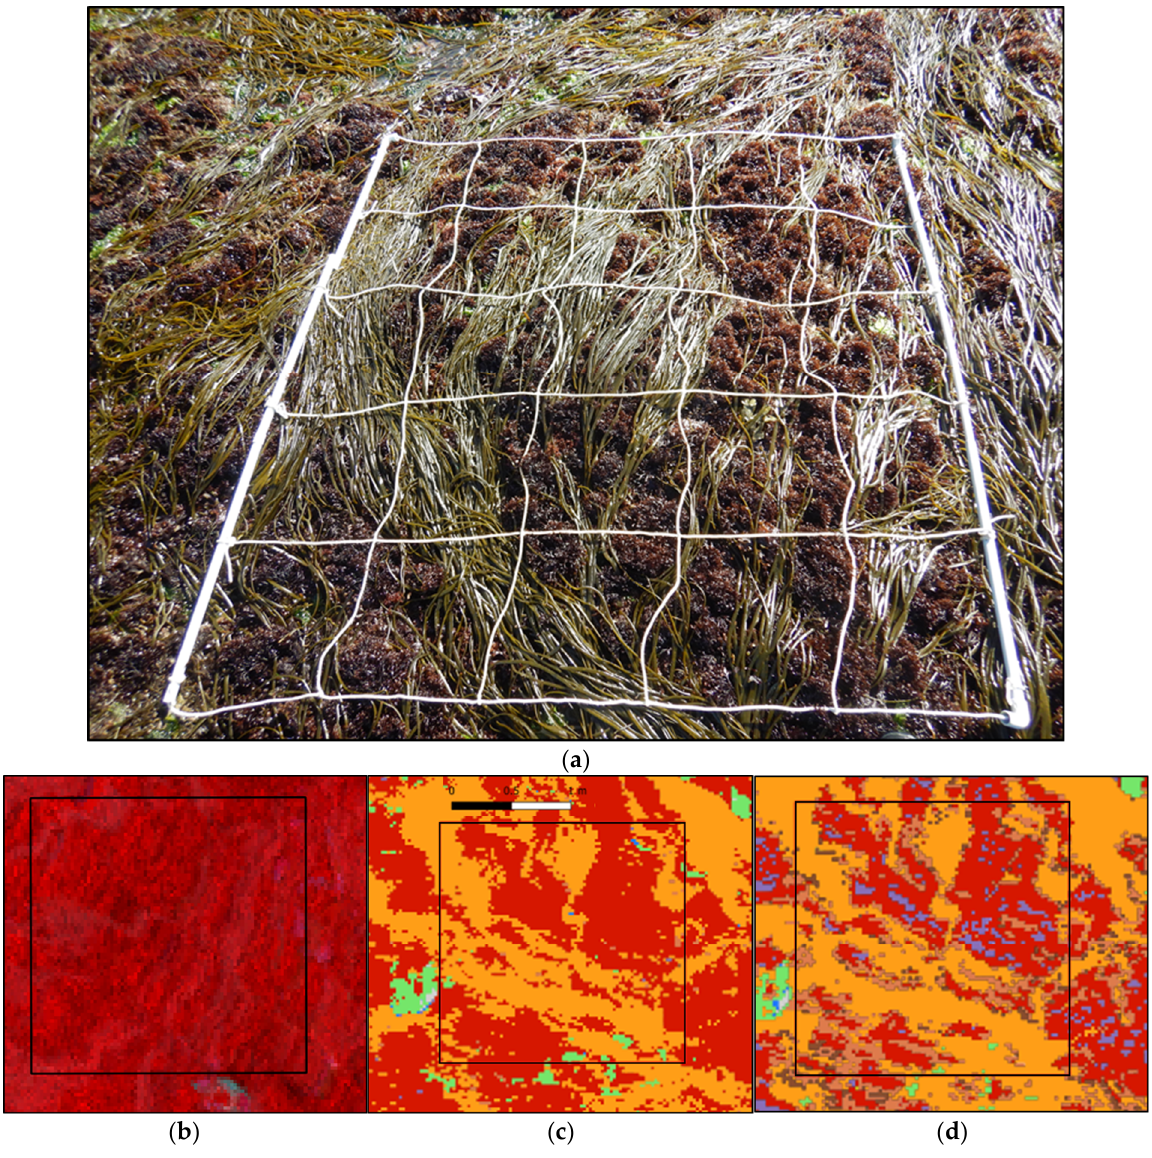
Figure A3. ( a ) Picture of a sampling spot on the He-Ld level at Porspoder taken during field sampling in April 2021. ( b ) NIR-G-B image of the same sampling spot. ( c ) Result of the MLC classification. ( d ) Result of the SAM classification. The black square corresponds to the mobile grid structure used for field sampling. Color code in ( c , d ) corresponds to the following classes: ‘ P. canaliculata ’ (brown), ‘ A. nodosum ’ (purple), ‘ F. serratus ’ (Coral), ‘ H. elongata ’ (orange), ‘Red’ algae (red), ‘Green’ algae (green), ‘Substratum’ (grey) and ‘Water’ (blue).